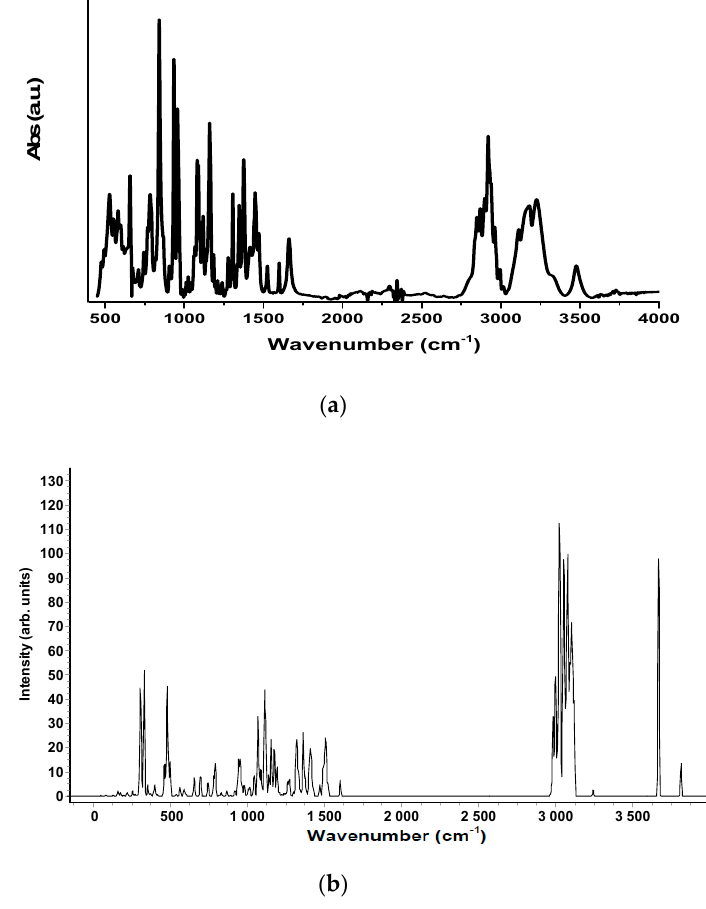
Figure 5. ( a ) FT-IR spectrum of stanozolone molecule in the wavenumber range 4000–400 cm − 1 ; ( b ) The simulated FT-IR spectra of stanozolone computed with a B3LYP/6-311G (d, p) level of theory. Table 1. Theoretical calculation (in cm − 1 ) of oxandrolone calculated by DFT (B3LYP/6-311G (d, p)) and its comparison with the experimental data.